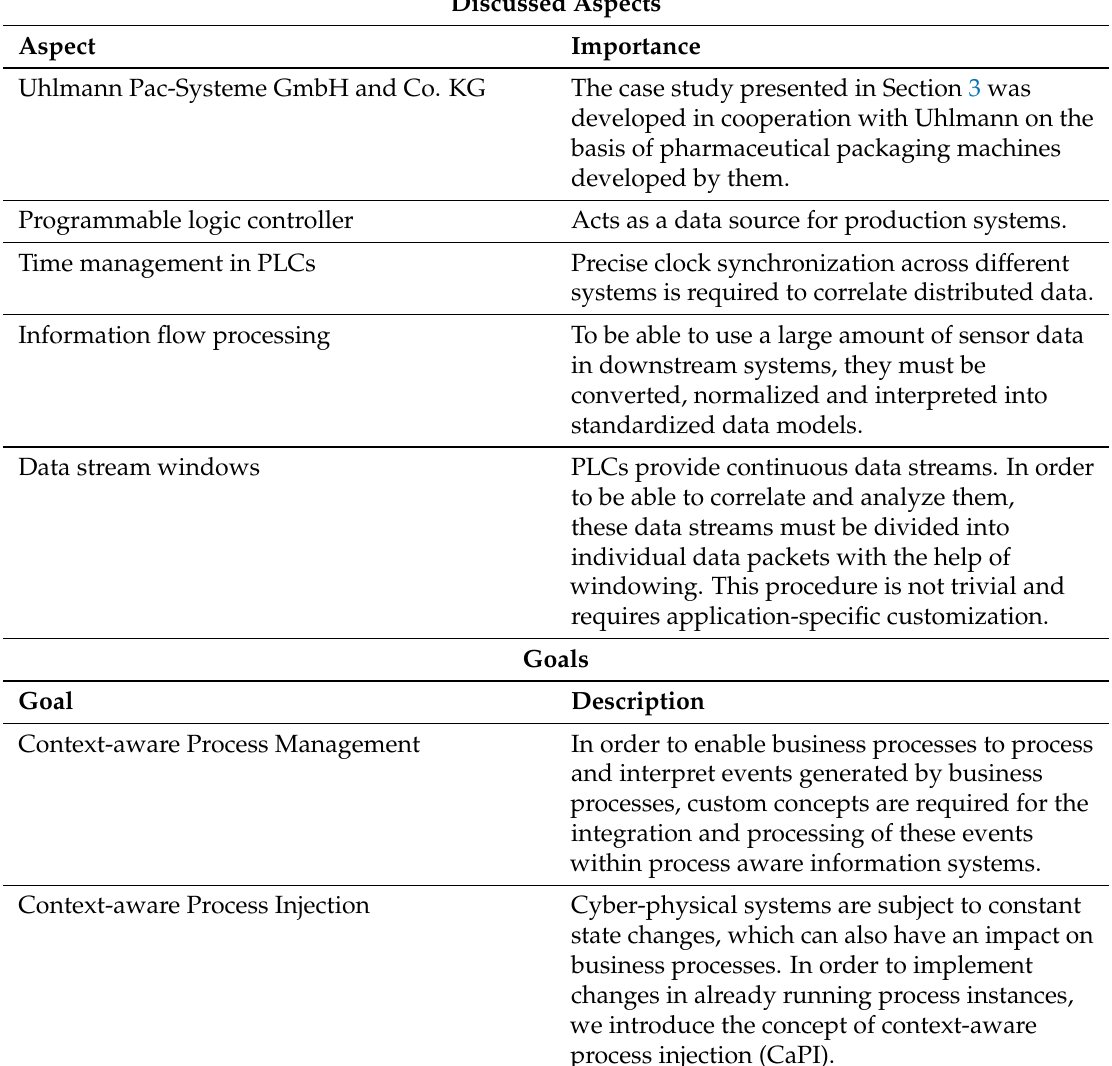
Table 2. Overview of discussed aspects and